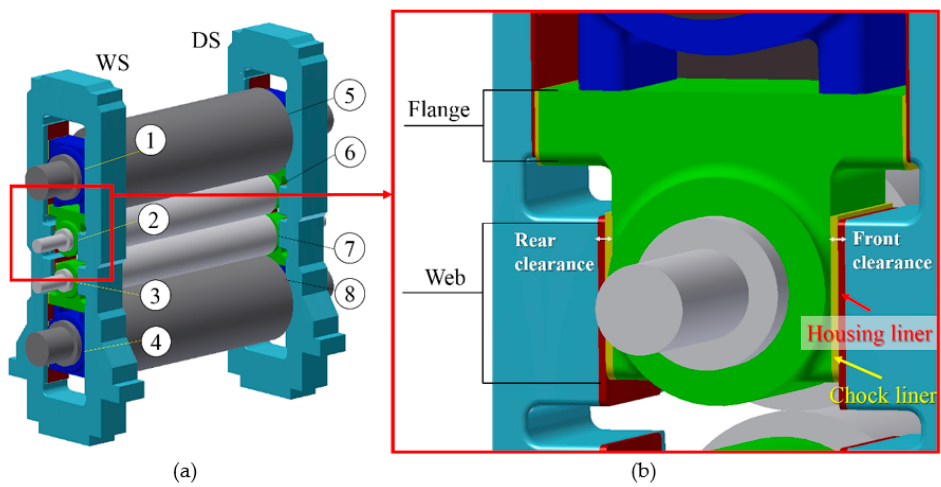
Figure 2. Illustration showing horizontal clearances ( C H ). ( a ) Location of horizontal clearances, ( b ) details of work roll chock clearances.